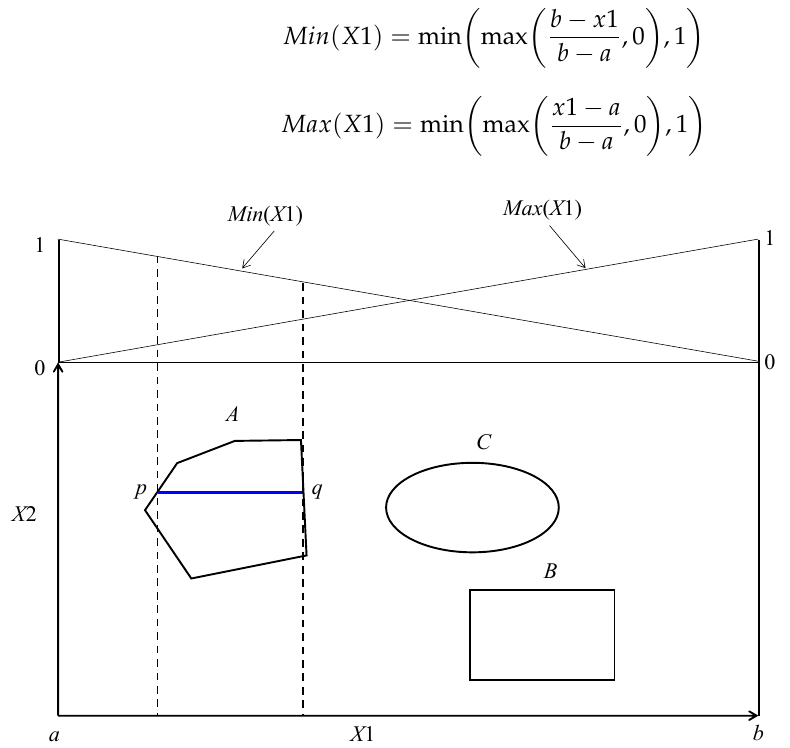
Figure 3. Compliance calculation for an interval.